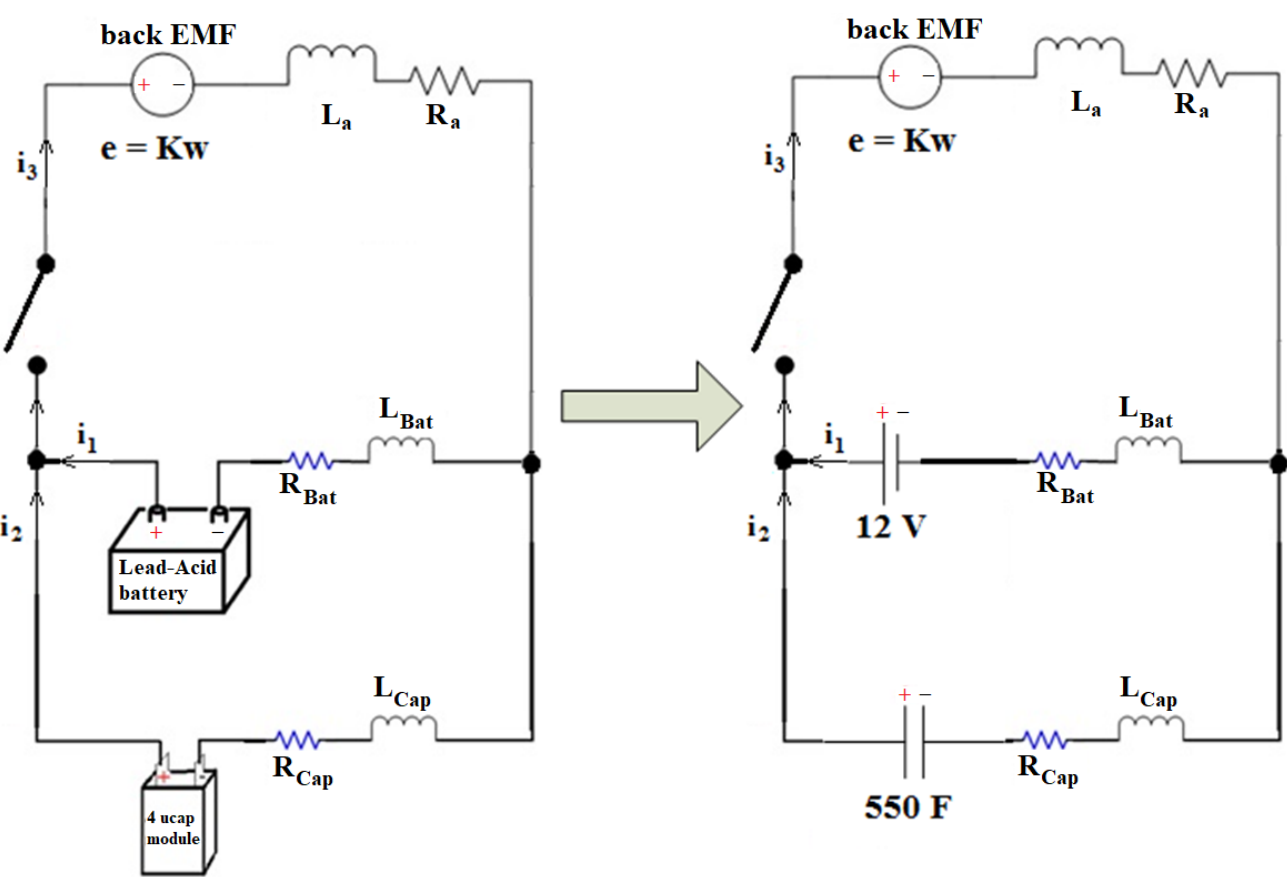
Figure 4. Cranking equivalent circuit for the PMDC starter motor.